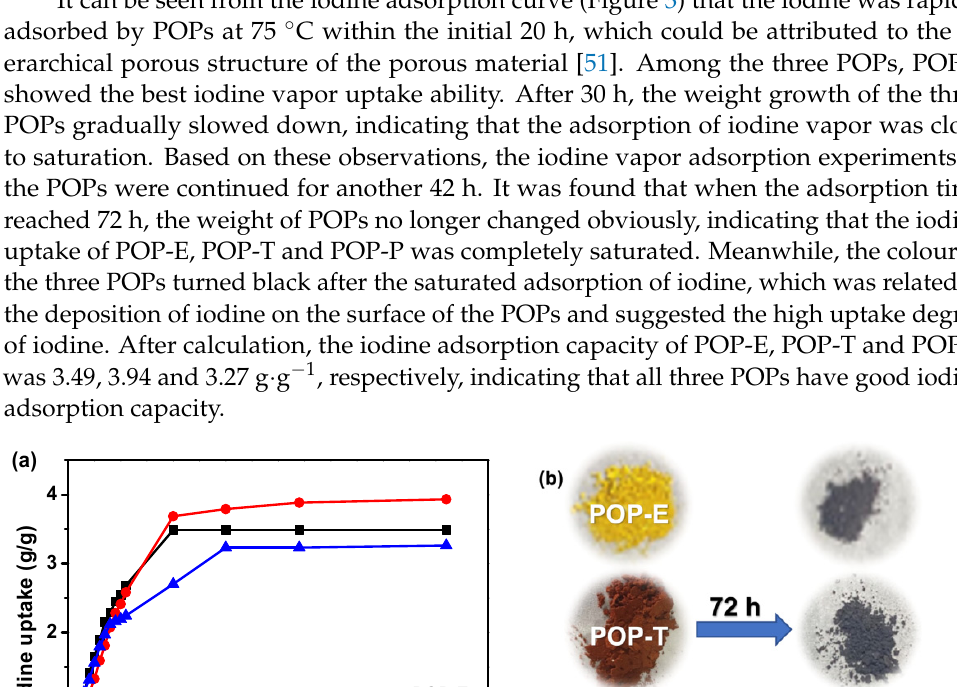
Figure 2. ( a ) Nitrogen adsorption/desorption isotherms of POP-E, POP-T and POP-P. ( b ) Pore size distributions of POP-E, POP-T and POP-P.